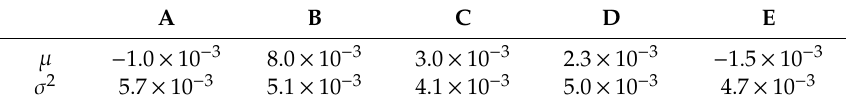
Table 1. First- and second-order moments of refrigerant flow